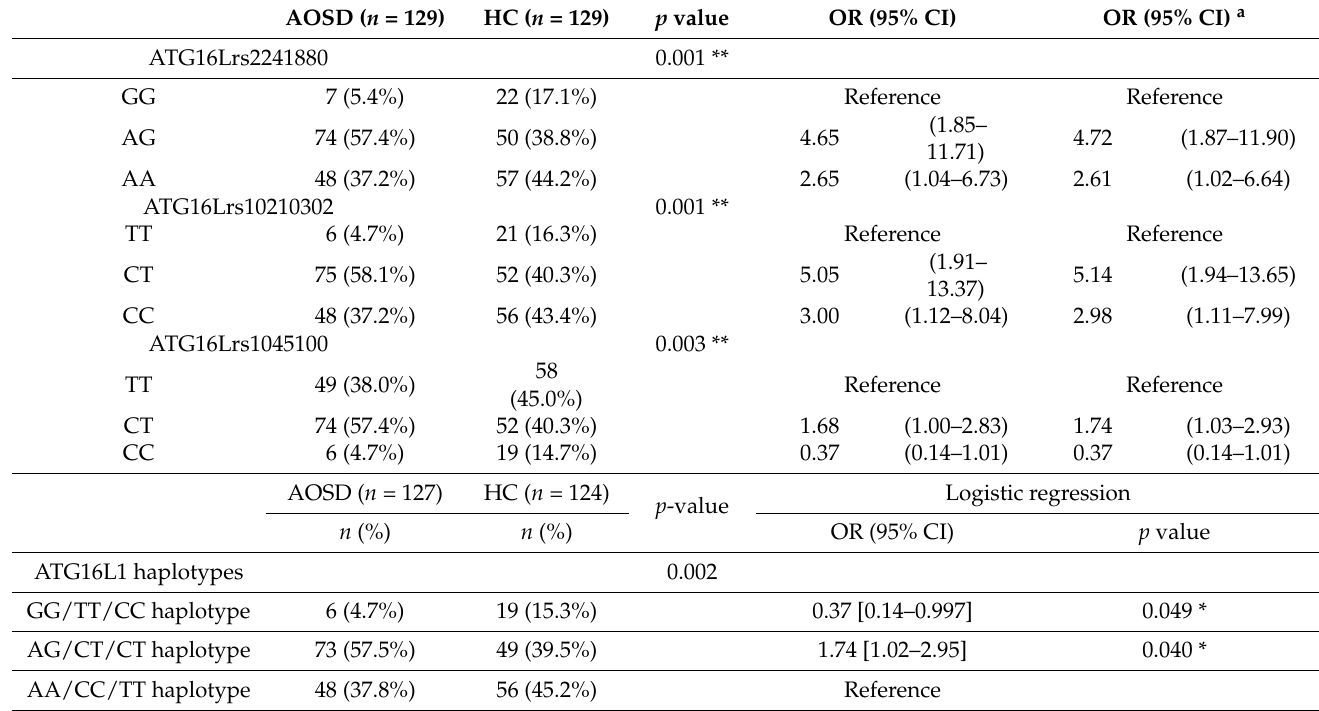
Table 2. Direct sequencing demonstrated that the frequencies of ATG16L1 polymorphisms and haplotypes were associated with susceptibility to AOSD.